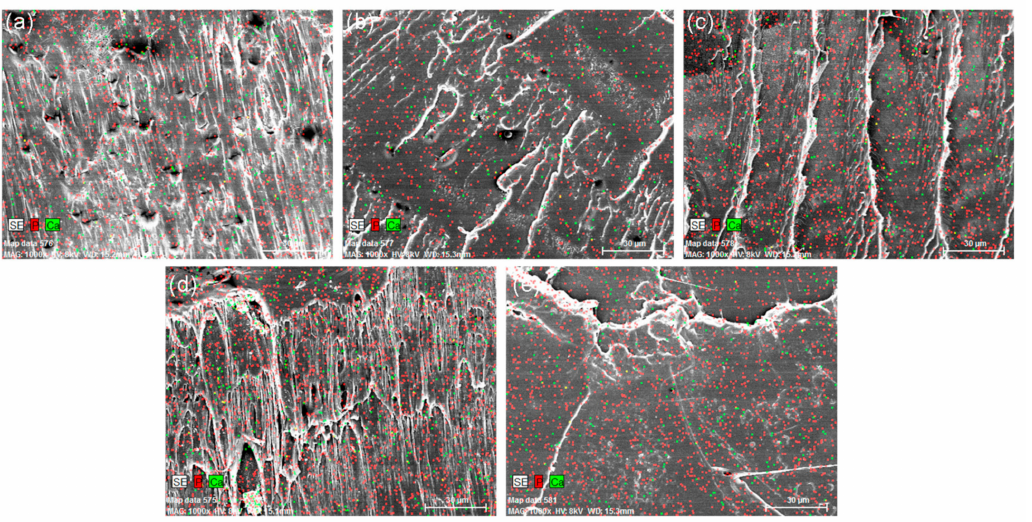
Figure 10. Energy Dispersive Spectrometer (EDS) of ( a ) PLA / A1, ( b ) PLA / A2, ( c ) PLA / A3, ( d ) PLA / A4, ( e ) PLA / A5.